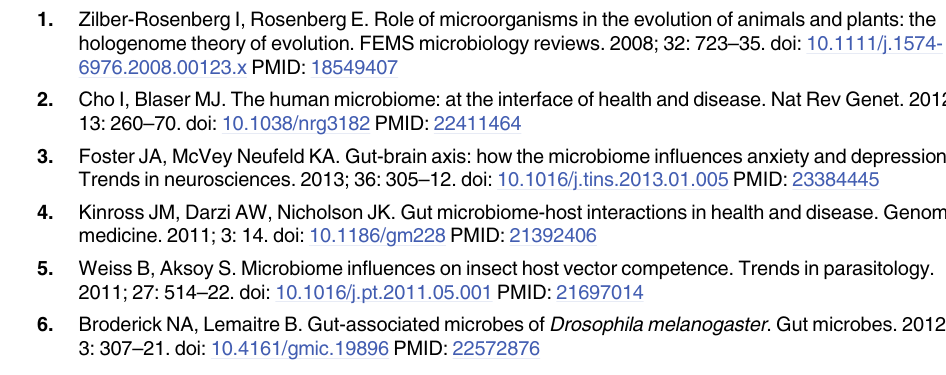
S2 Fig. Mean female midgut length vs. mean male midgut length in 9 fly lines. Each point represents a separate fly genotype. Male and female length measurements strongly correlate (R 2 = 0.8781). S1 Table. Mean bacterial load in male flies from the 36 lines. The values given are the means of the model residuals after accounting for experimental variables. S2 Table. ROS levels in male fly intestines as measured with the ferric-xylenol orange (FOX) assay [34]. The values given are the means of the model residuals after accounting for experimental variables. S3 Table. Variants associated with bacterial load at an FDR of 0.05. S4 Table. Significantly enriched GO terms from analysis with GOrilla and